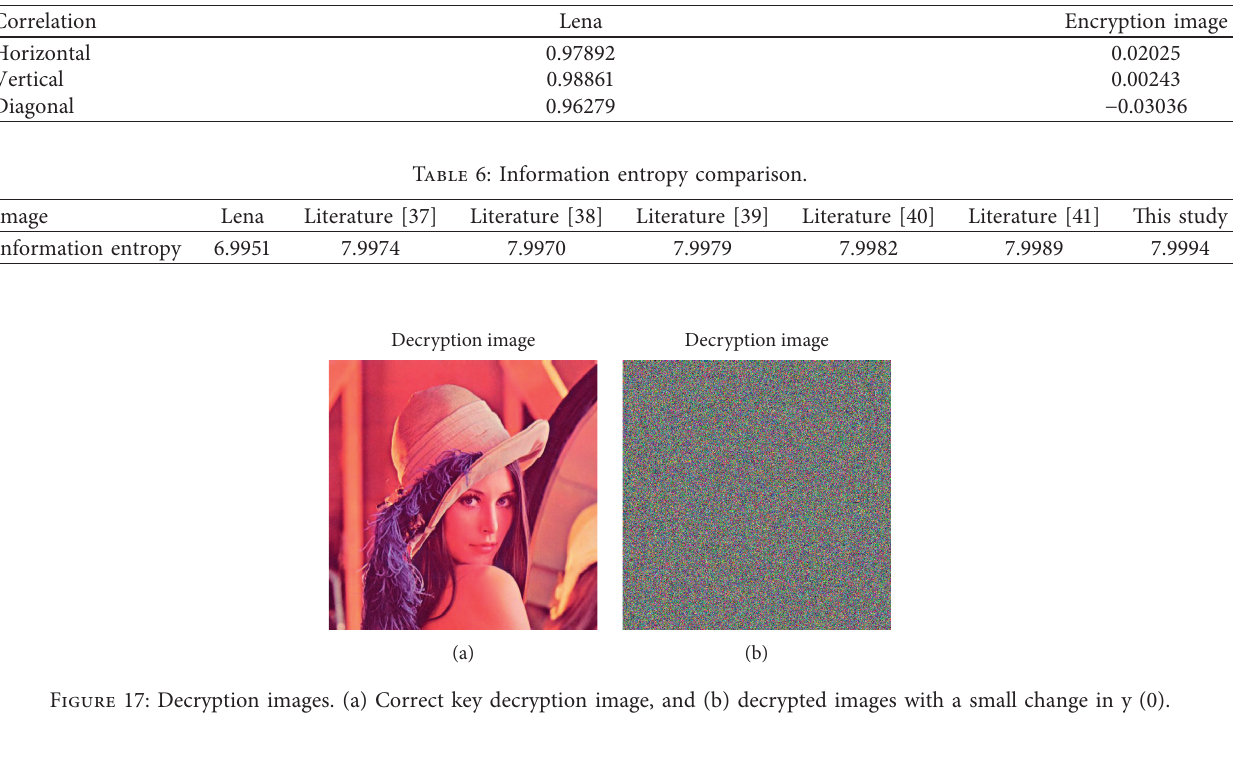
Figure 16: Partial correlations of adjacent pixels. (a) Horizontal correlation of the original image in the R channel, (b) horizontal correlation of the ciphered image in the R channel, (c) vertical correlation of the original image in the G channel, (d) vertical correlation of the ciphered image in the G channel, (e) diagonal correlation of the original image in the B channel, and (f) diagonal correlation of the ciphered image in the B channel. Table 5: Comparison of correlation coefficients.